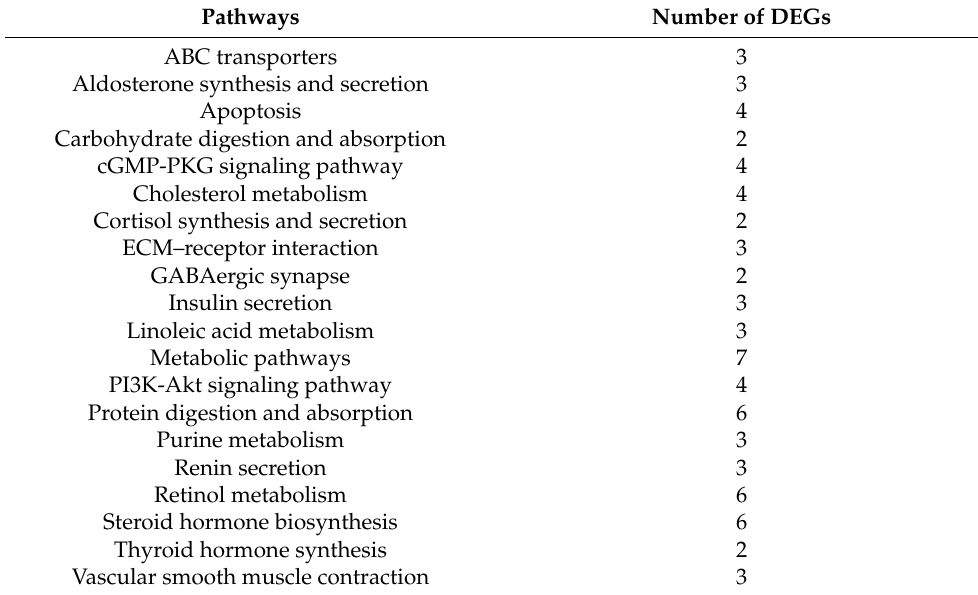
Table 1. Metabolic pathways